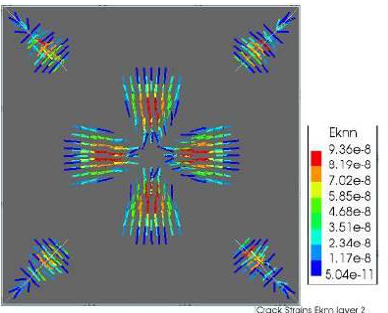
Figure 15. The crack strains result of nonlinear analysis on the medium surface of the first model with pinned constraint.